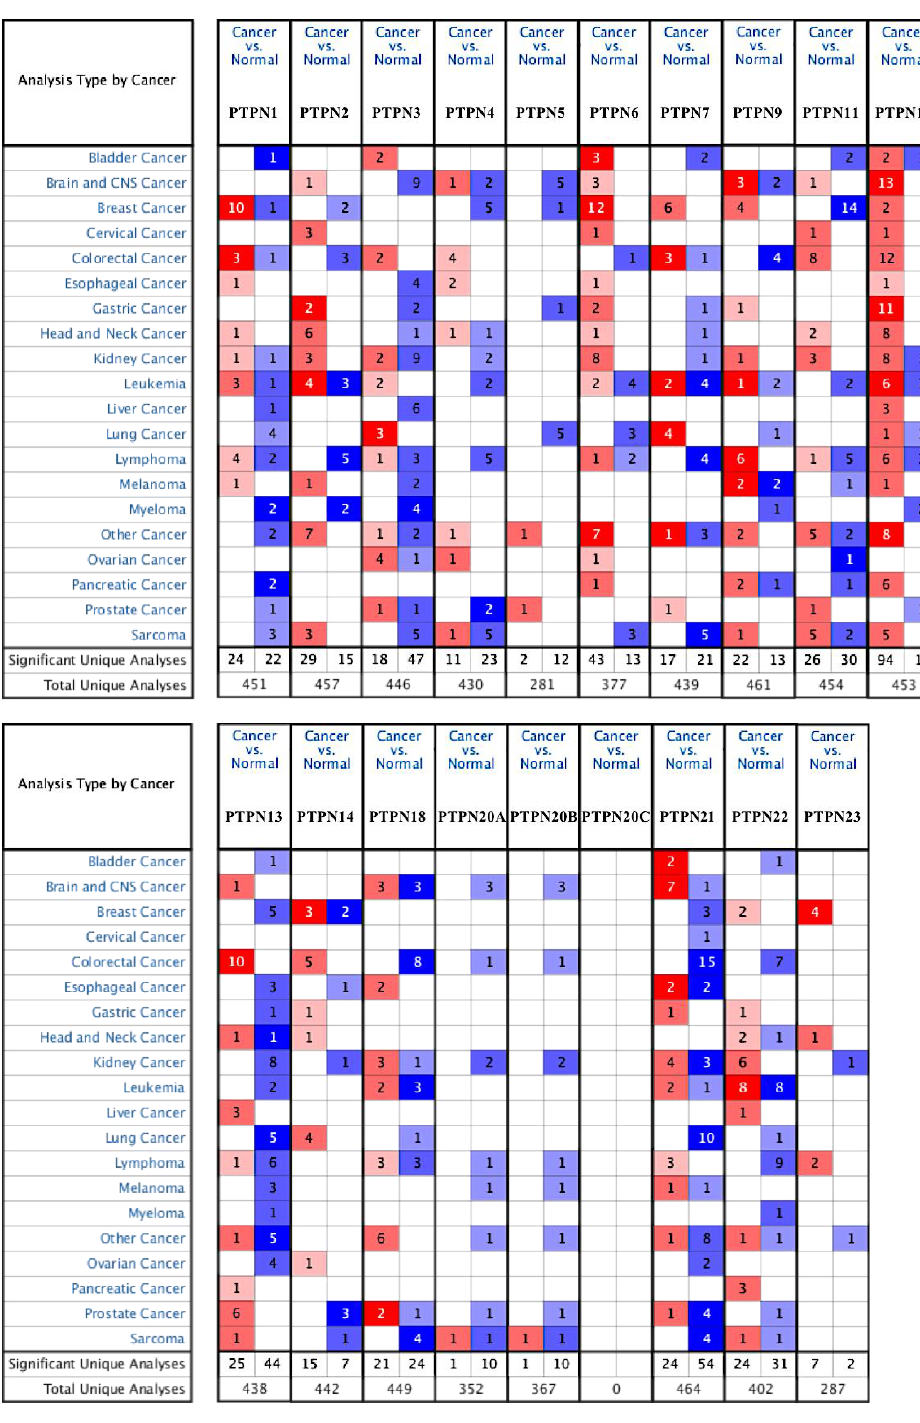
Figure 1. Transcription levels of protein tyrosine phosphatase non-receptor type (PTPN) family genes in different types of cancers. The thresholds of the p value and fold change were as follows: p = 0.01, fold change = 1.5, gene rank = 10%.